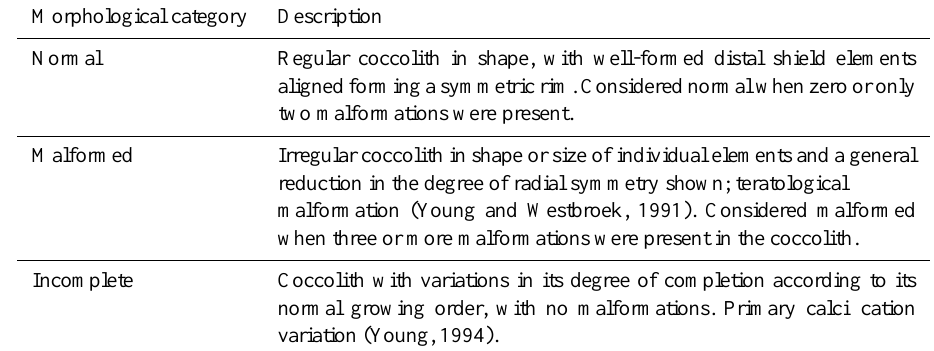
Table 3. Morphological categorization of coccoliths (from SEM images) of E. huxleyi used in this study. Morphological category Description Normal Regular coccolith in shape, with well-formed distal shield elements aligned forming a symmetric rim. Considered normal when zero or only two malformations were present. Malformed Irregular coccolith in shape or size of individual elements and a general reduction in the degree of radial symmetry shown; teratological malformation (Young and Westbroek, 1991). Considered malformed when three or more malformations were present in the coccolith. Incomplete Coccolith with variations in its degree of completion according to its normal growing order, with no malformations. Primary calcification variation (Young,